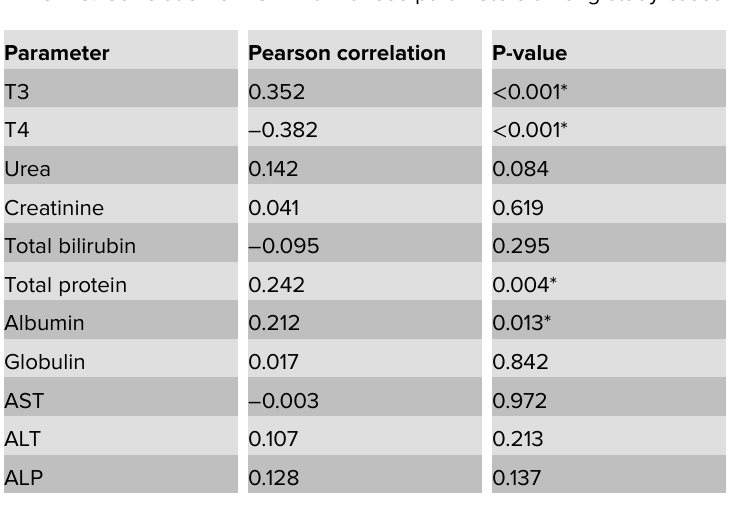
Comparison of KFT parameters in cases with TSH 6.5–8 mIU/L and controls Parameter Cases (n = 49) Controls (TSH < 2.5